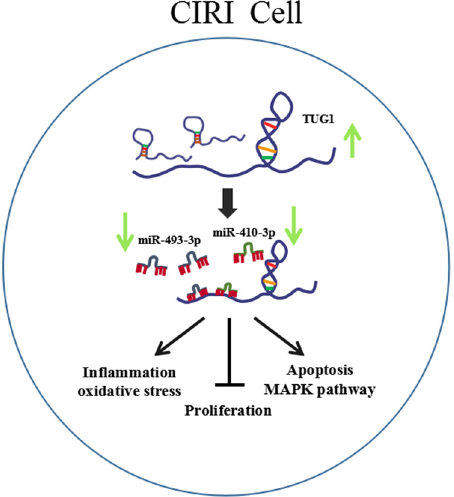
Figure 8: Schematic diagram of TUG1 involved in CIRI regulation. TUG1 was highly expressed in the serum of CIRI patients. TUG1 inhibited the proliferation, promoted in fl ammation, oxidative stress and apoptosis, cytotoxicity and activated JNK and p38 pathways by sponging miR - 493 - 3p or miR - 410 - 3p in CIRI